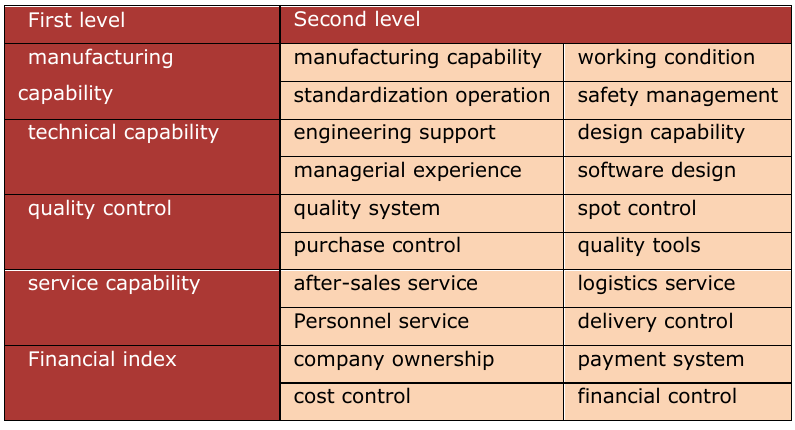
Table 1. Supplier Evaluation Index